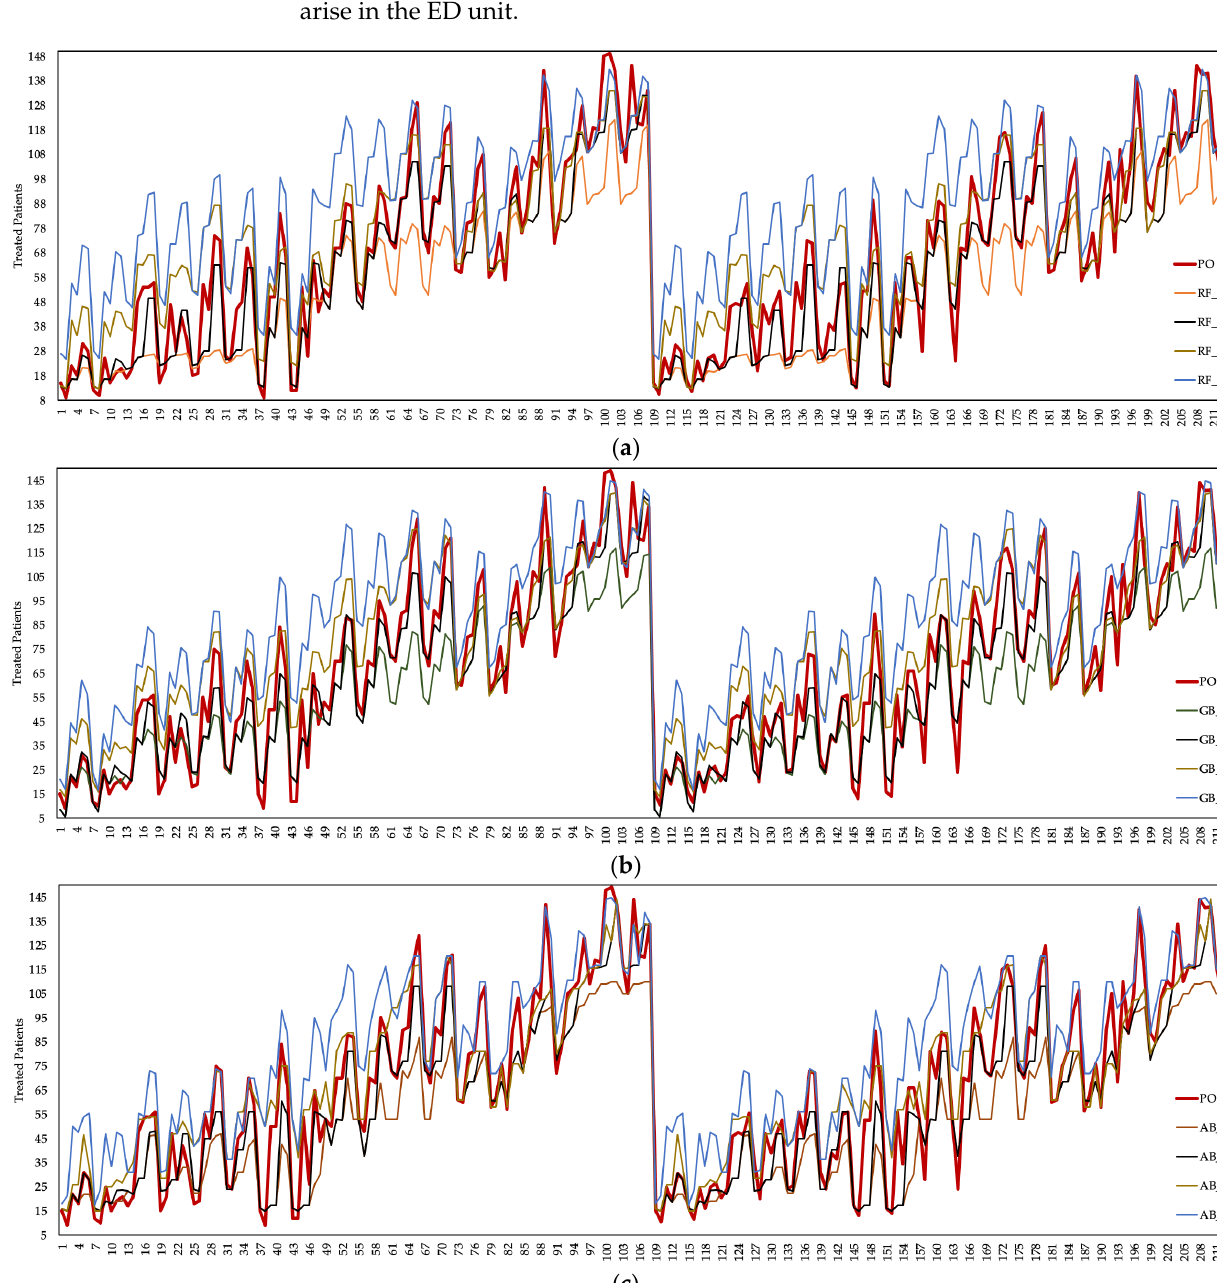
Figure 5. The estimated p nt based on the ( a ) RF algorithm ( δ 0.0 for RF − 0 , δ 0.1 for RF − 1 , δ 0.2 for RF − 2 for RF − 3 ), ( b ) GB algorithm ( δ 0.0 for GB − 0 , δ 0.1 for GB − 1 , δ 0.2 for GB − 2 , δ 0.3 for GB − 3 ) ( c ) AB algorithm ( δ 0.0 for AB − 0 , δ 0.1 for AB − 1 , δ 0.2 for AB − 2 , δ 0.3 for AB − 3